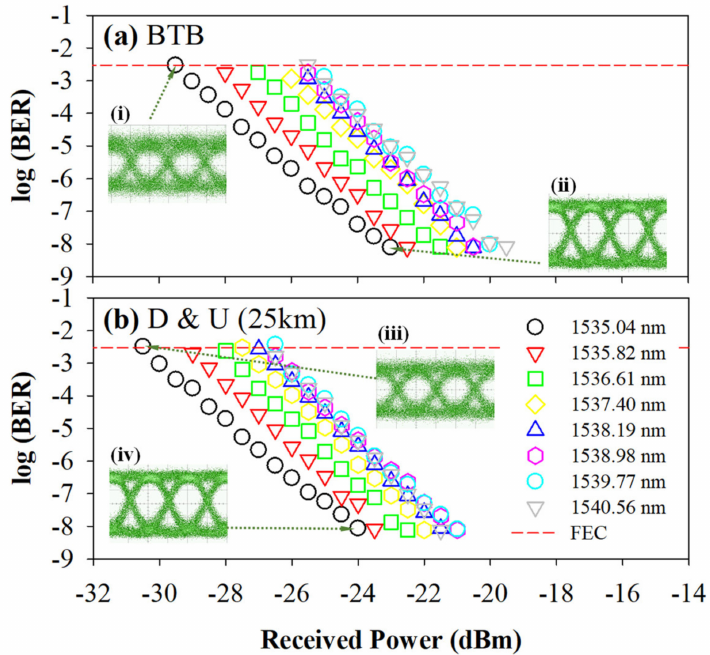
Figure 6. Measured BER performances of λ 1C to λ 8C ( a ) at the BTB state and ( b ) through 25 km SMF, respectively. Insets (i) to (iv) are the observed corresponding eye diagrams under different received